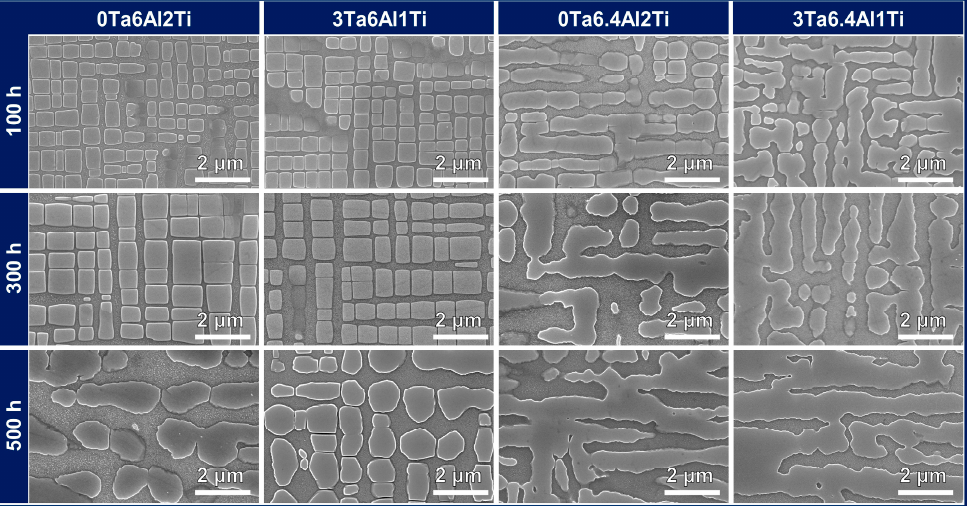
Figure 8. Microstructure evolution of 0Ta6Al2Ti, 3Ta6Al1Ti, Ta6.4Al2Ti, and 3Ta6.4Al1Ti alloys after thermal exposure at 1050 °C for up to 500 h. The microscopic observations identify no TCP phase formation at different exposure times in all alloys.